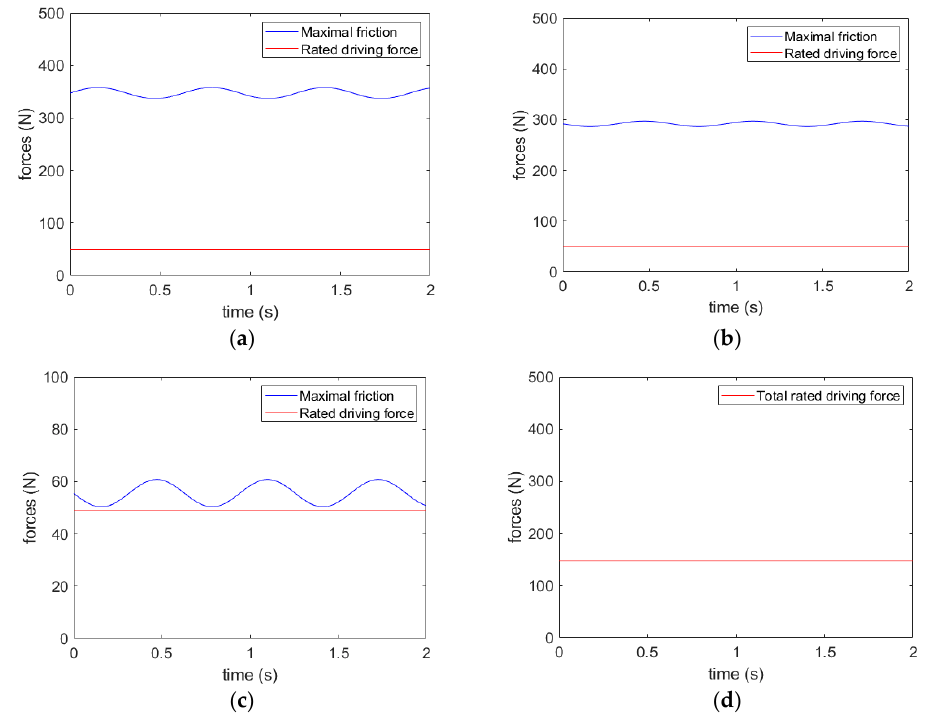
Figure 8. Changes in friction forces on the rolling wheels. ( a ) Rolling wheel A; ( b ) Rolling wheel B; ( c ) Rolling wheel C; ( d ) The payload of the robot.